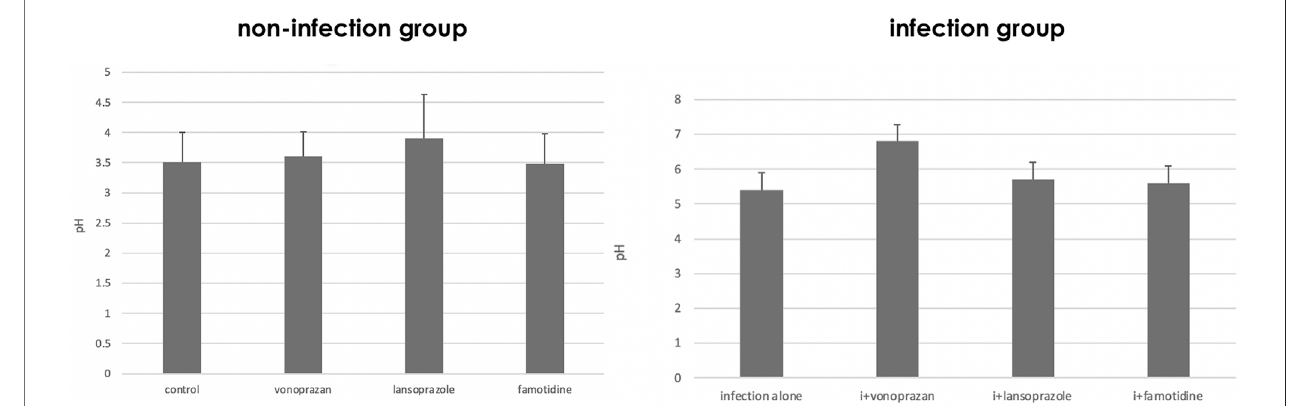
FIGURE 1 | Alteration of gastric pH by acid suppressants and NHPH infection. A signi fi cant interaction was found between infection and acid suppressants in the gastric mucosal pH (F = 3.04 and p = 0.043 by two-way ANOVA). In the infection group, vonoprazan treatment induced the highest increase in intragastric pH. i means infection in the left graph.